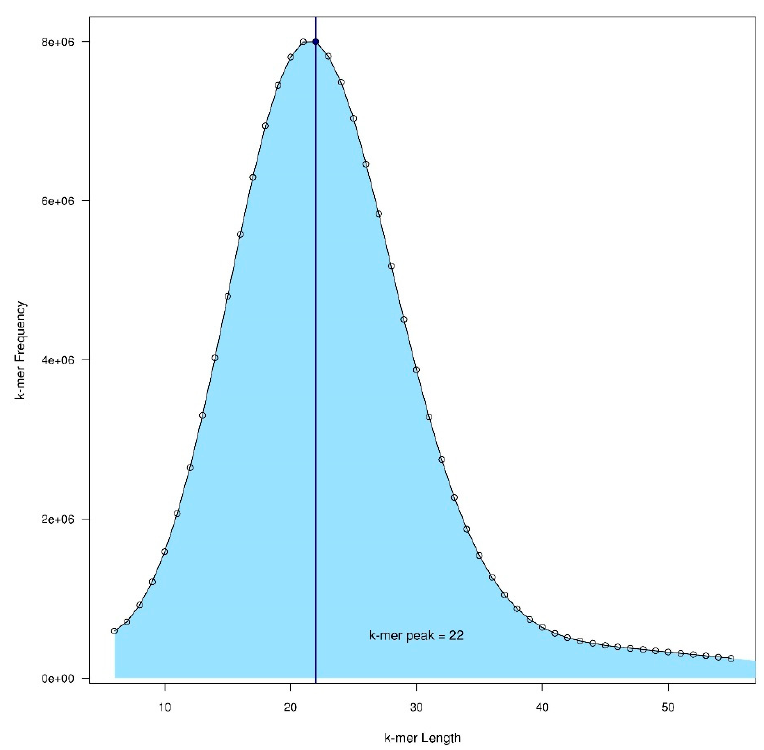
Figure 1. Plot of k-mer frequency by length produced for Camelina neglecta J.Brock, Mandáková, Lysak & Al-Shehbaz produced using Jellyfish and visualized using R. The position of the peak at a k-mer length of 22 is used to calculate genome size based on the area under the curve as represented by the light blue region. Here the genome size estimated is 248 Mb, while flow cytometry estimates indicate a genome size of 264 (±9) Mbp [80].